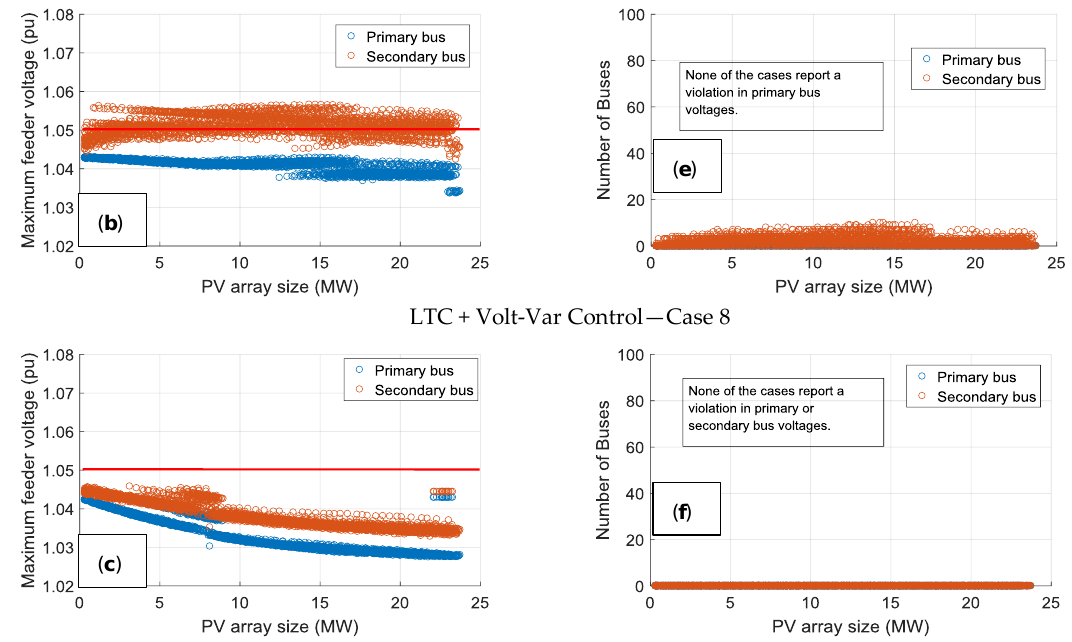
Figure 9. Cases 6, 7, 8: Legacy device control and smart inverter control: ( a – c ) Largest feeder voltages; ( d – f ) Number of bus voltage violations.